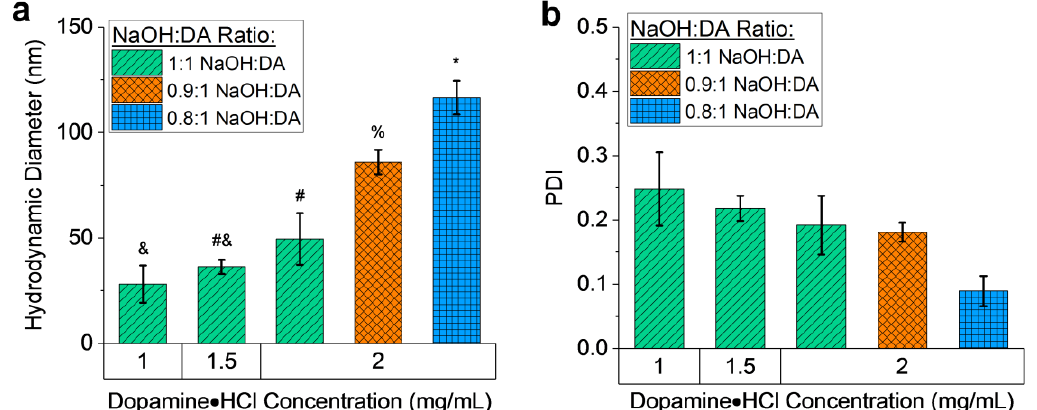
Figure 2. Dynamic light scattering (DLS) analysis of MMNPs. ( a ) Mean hydrodynamic diameters and ( b ) polydispersity indices (PDI) of multiple batches of MMNPs prepared at various dopamine·HCl (DA) concentrations and NaOH:DA ratios. n = 3 − 19 independently prepared batches of MMNPs were analyzed for each synthetic condition. Error bars represent standard deviations. Bars not sharing symbols in ( a ) differ significantly with p < 0.001.